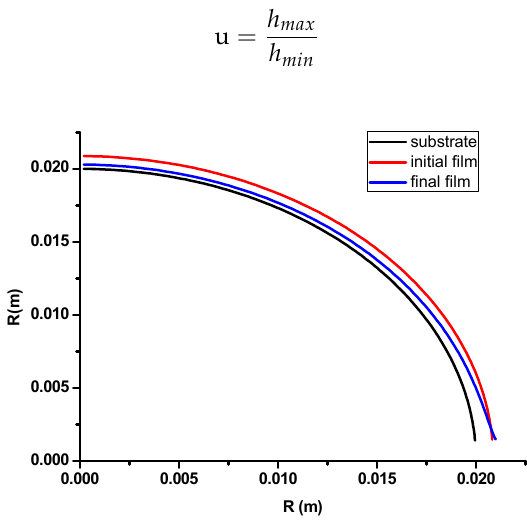
Figure 5. Schematic of film contour evolution on a sphere.